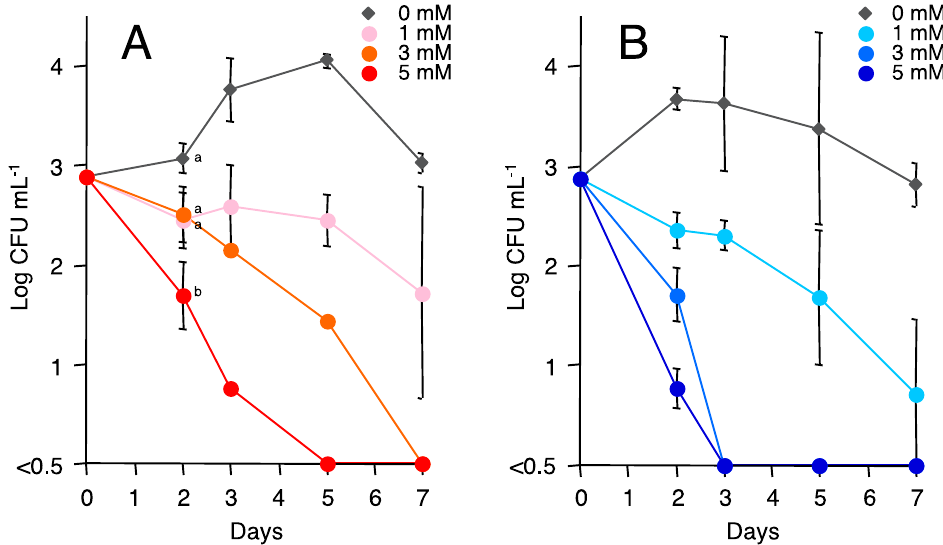
Figure 4. Viable number of Fusarium oxysporum f. sp. lycopersici conidia incubated at 30 °C in MES buffer adjusted at pH 5.5 ( A ) and pH 5.0 ( B ). The buffer contained 0 to 5 mM of caproate. Values are expressed as means of Log colony forming unit (CFU) of Fol conidia mL − 1 ±1.96 × standard error, when a normal distribution is assumed. Symbols with different alphabets indicate statistically significant differences based on Tukey’s HSD ( α = 0.05).